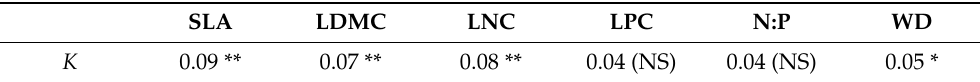
Table 2. Phylogenetic signal, as measured by Blomberg’s K , in functional traits of forest vegetation across climatic regions in China. * p < 0.05; ** p < 0.01; NS,